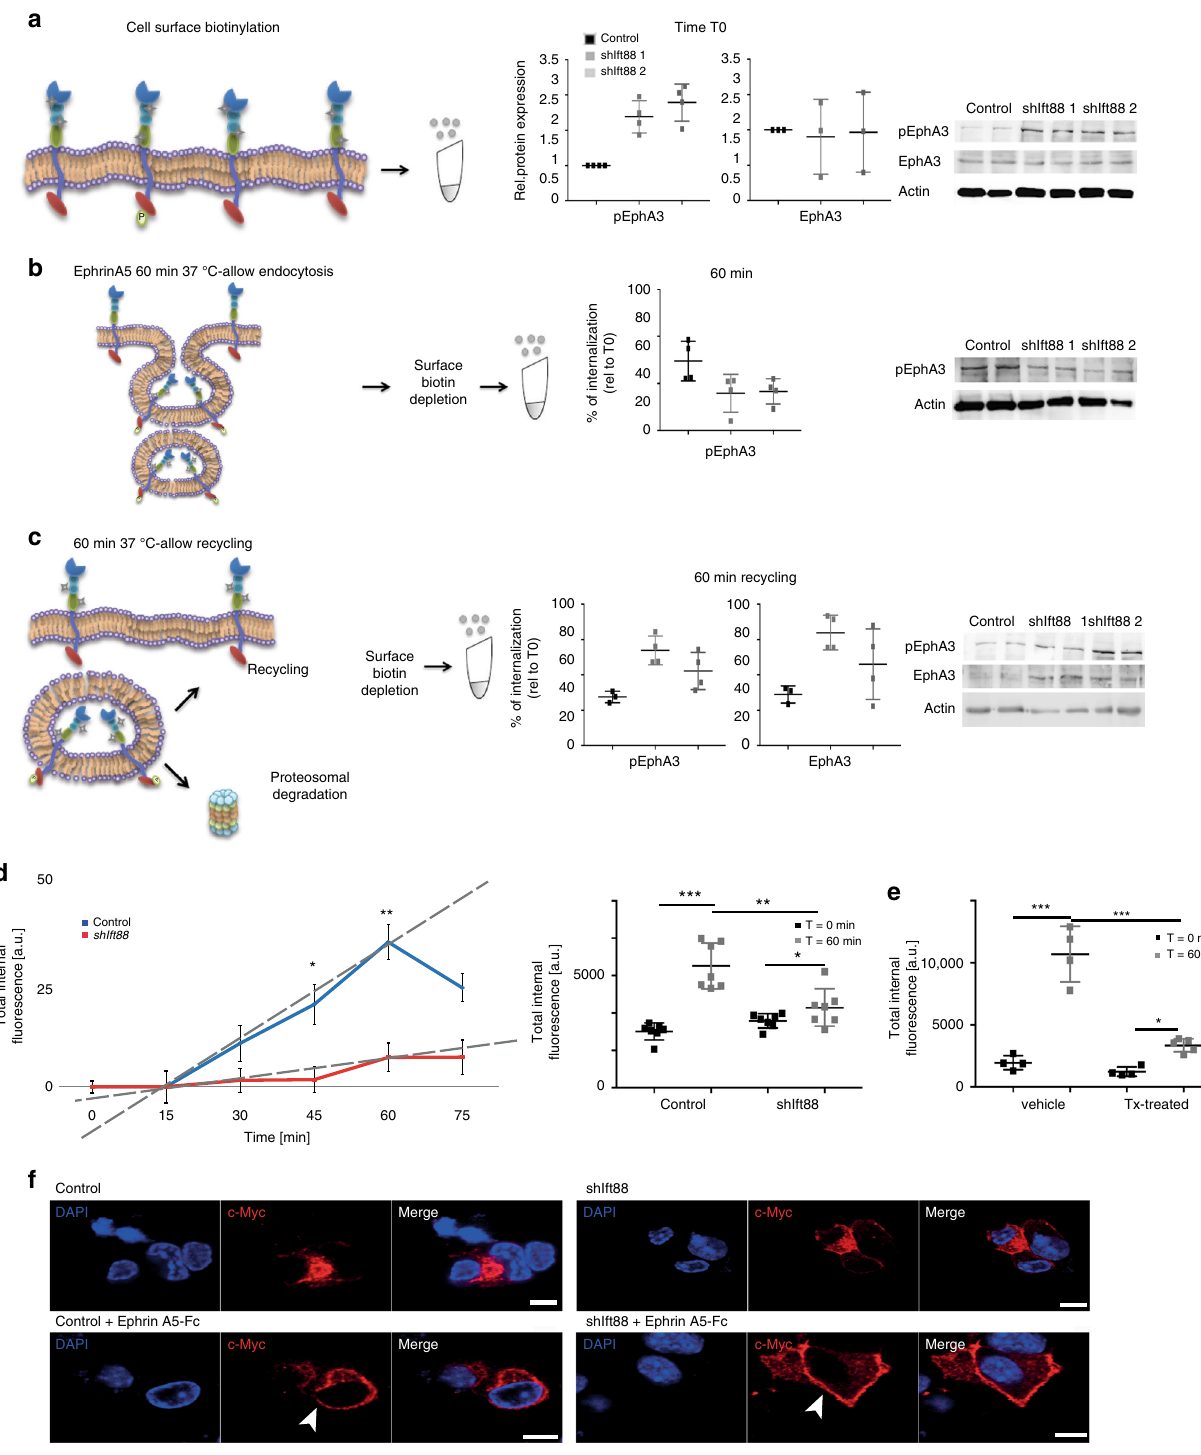
Fig. 4 Vesicular traf fi cking to the endosomal recycling compartment depends on Ift88 function. a EphA3 and pEphA3 at the cell surface, mean ± s.d. b Internalized pEphA3, mean ± s.d. c . pEphA3 and EphA3 in the cytoplasm after internalization and before recycling back to the cell surface, mean ± s.d. d EphrinA5 uptake in shIft88 cells. Biotinylated EphrinA5 was visualized with Streptavidin-AlexaFluor 647 ( t = 45 min: p = 0.0379; t = 60 min: p = 0.0062; t = 75 min: p = 0.0329 ( t test), mean ± s.d.), discontinuous lines show different slopes, on the side dot plots of t = 60 min compared with t = 0 min in both cell lines. e EphrinA5 uptake in Tx- and veh-treated β ICKO islets ( n = 3, Δ (vehicle): p = 0.0001; Δ (treated): p = 0.0132; vehicle t = 60 min vs treated t = 60 min: p = 0.0001 ( t test), mean ± s.d.). f c-Myc-EphA3 (red) localization in shIft88 expressing MIN6m9 cells with or without Ephrin A5-FC (1 h prior experiment). Scale bar 5 µ